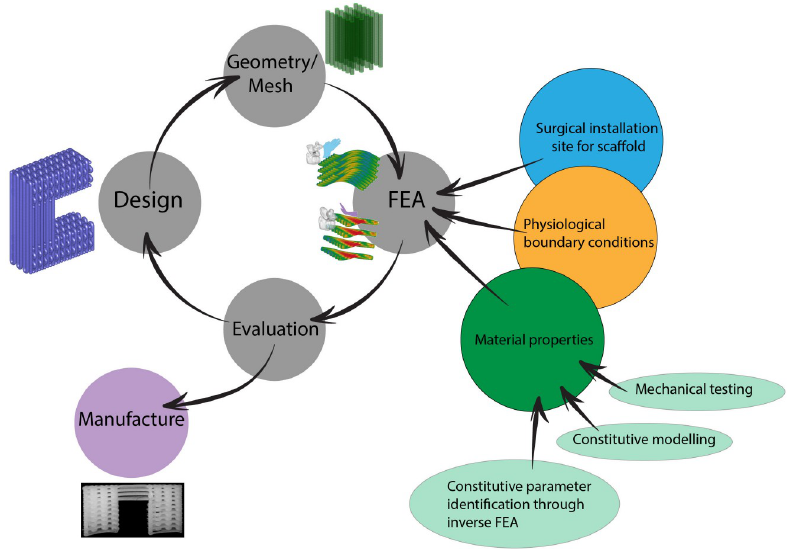
Fig 3. Schematic overview of the computational